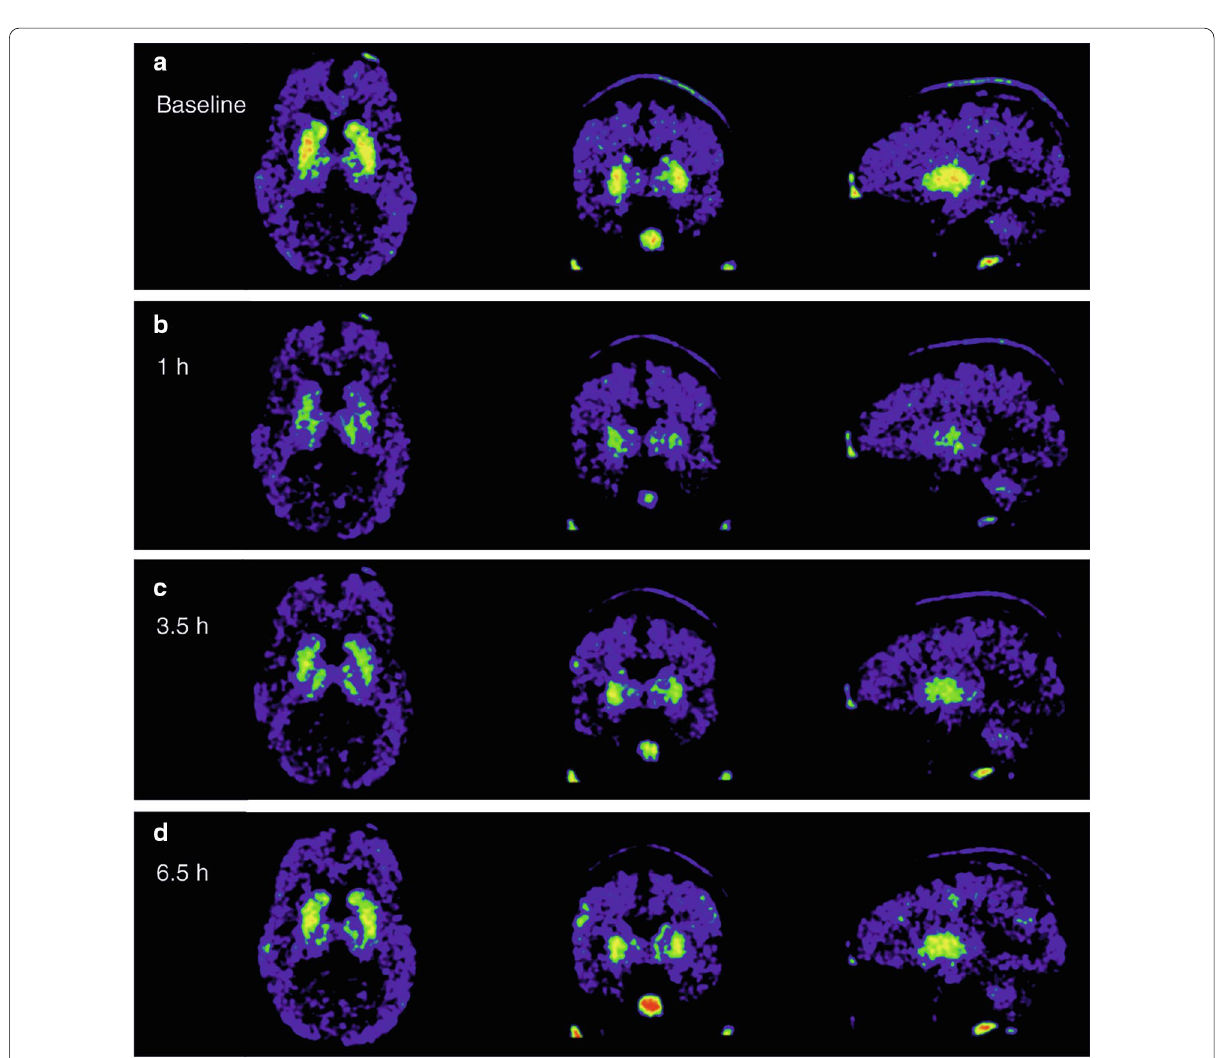
Fig. 3 A representative set of human brain PET SUV images from one healthy male volunteer at baseline and 1 h, 3.5 h and 6.5 h after 60 mg of